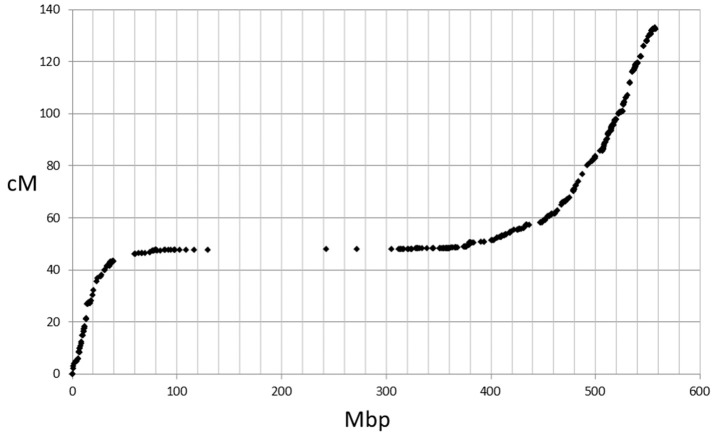
Plot of 9k SNP marker genetic map positions vs. physical map positions for chromosome 1H.